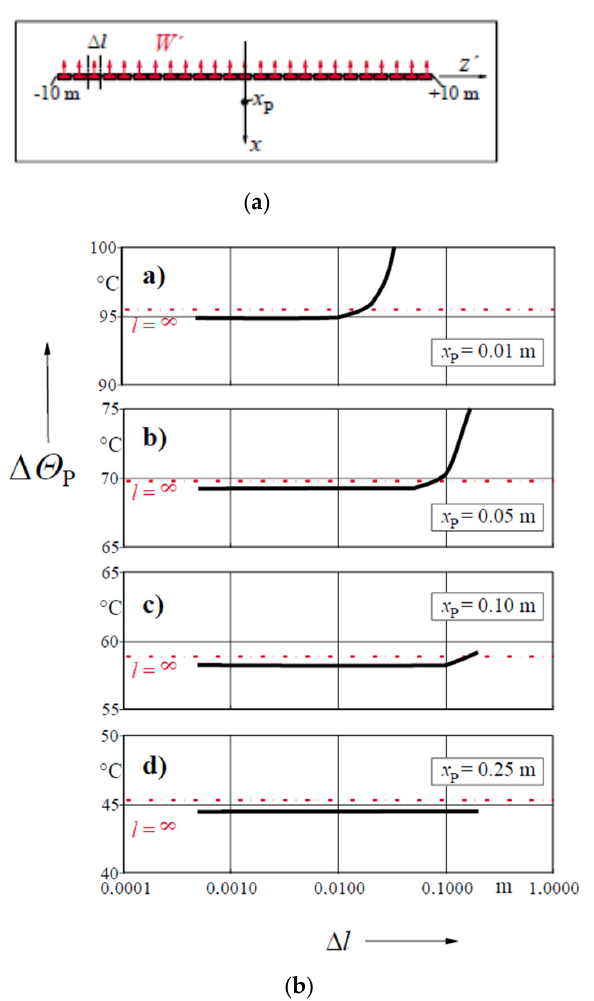
Figure 3. Temperature rise in the middle of a line source from z’ = − 10 m to z’ = +10 m and in a distance xP from its axis (at z’ = 0), as a function of the length Δ l. The line source is represented by point sources of length Δ l and losses (p.u.l.) of W’ = 100 W/m; depth: y = 2.0 m (dotted: infinite line source). The first diagram ( a ) shows the location of point xp with respect to the line source with the parameter the distance of this point from the center line [Figures a) to d)].